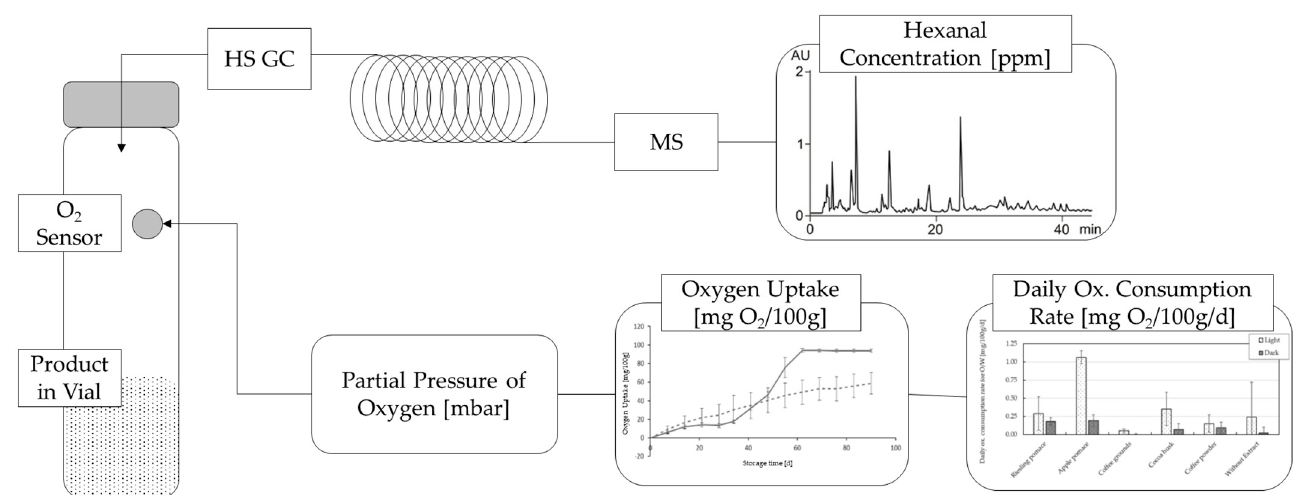
Figure 1. Scheme for the experimental setup for measuring the oxidation kinetics and oxidation products of emulsions during an accelerated storage test.